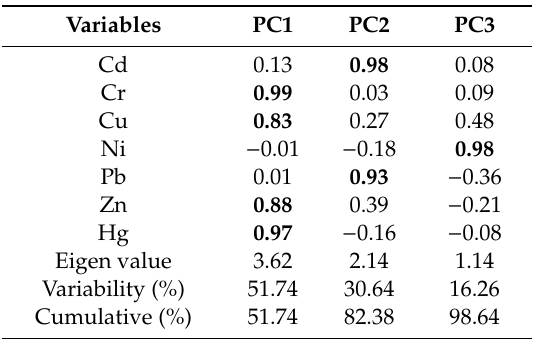
Table 12. Loadings of the variables on the significant principal components for the heavy metals in the dewatered and/or hygienized sewage sludge samples.